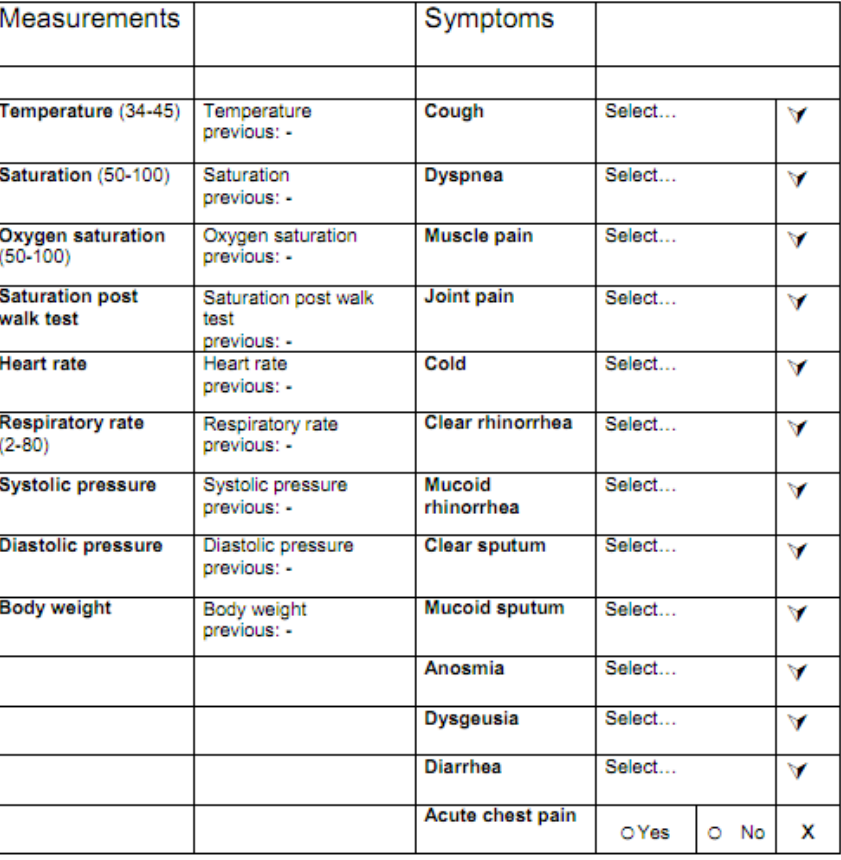
Figure 2. Form for monitoring clinical parameters and symptoms.